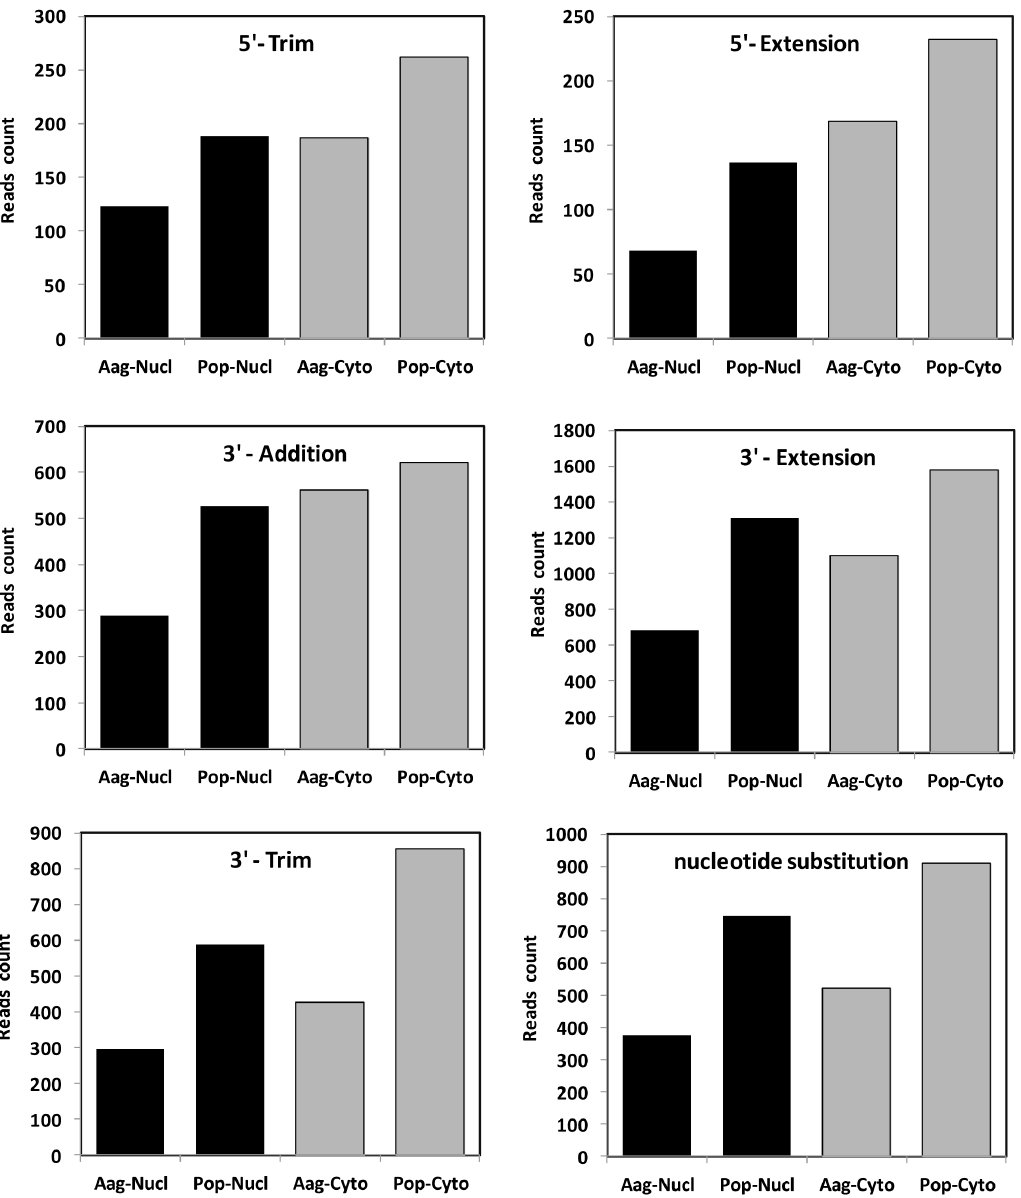
Figure 9. IsomiR analysis of detected miRNAs in four different libraries of Ae.aegypti cells in the presence and absence of Wolbachia. ‘‘5 9 trimmed (5 9 -Trim): The read aligns to a position in the hairpin after the reference mature sequence, but the last base of the read and the mature sequence map to the same position (they end at the same position). 3 9 trimmed (3 9 -Trim): the read is shorter than the reference mature sequence, but it starts at the same position in the hairpin. Nucleotide Substitutions: Sequence variation between the reference mature sequence and the read. Only those reads are considered that have the same length as the mature sequence, and that start at the same position within the hairpin sequence. Nucleotide Addition in 3 9 (3 9 -Addition): The read is at least two nucleotides longer than the reference mature sequence, and the nucleotides do not align with the hairpin sequence . Nucleotide extension in 3 9 (3 9 -Extension): The read is at least two nucleotides longer than the reference mature sequence, but the nucleotides align with the hairpin sequence. Nucleotide extension in 5 9 (5 9 -extension): The read aligns to a position in the hairpin before the reference mature sequence, but the last base of the read and the mature sequence map to the same position (they end at the same position). For nucleotide addition and extension, the read starts at the same position in the hairpin as the reference mature sequence.